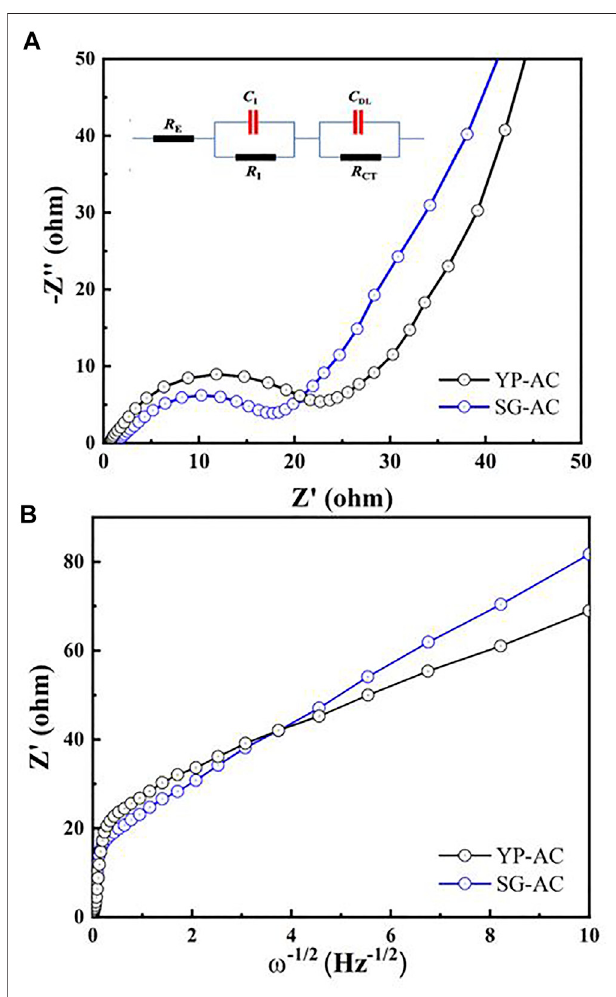
FIGURE 9 | (A) Nyquist plots of different capacitors at OCV, where an equivalent circuit was proposed for describing the impedance behavior within thefrequencyrangebetween100 kHzand1 Hz. (B) Randlesplotsofdifferent capacitors at open circuit voltage.